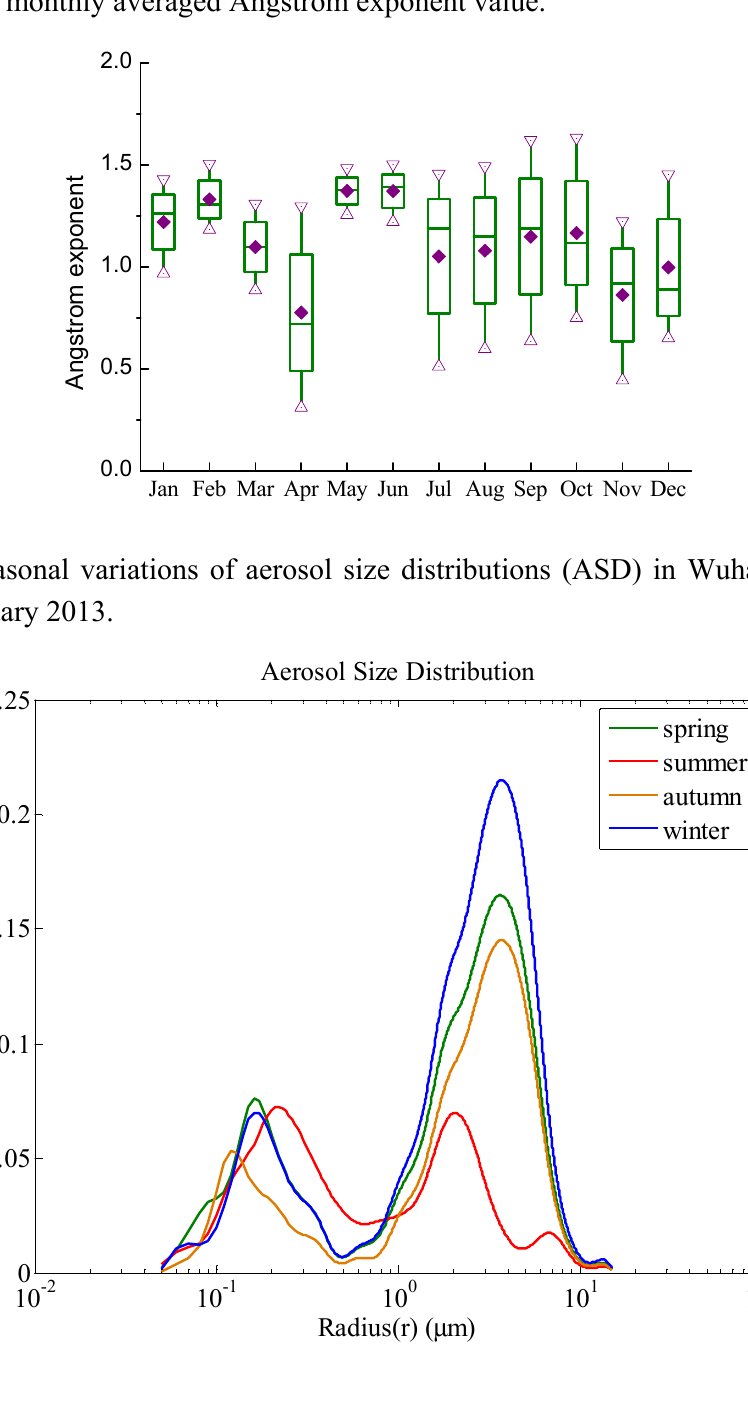
mean of the monthly maximum and monthly minimum; the triangles represent the represents the monthly averaged Ångström exponent value.